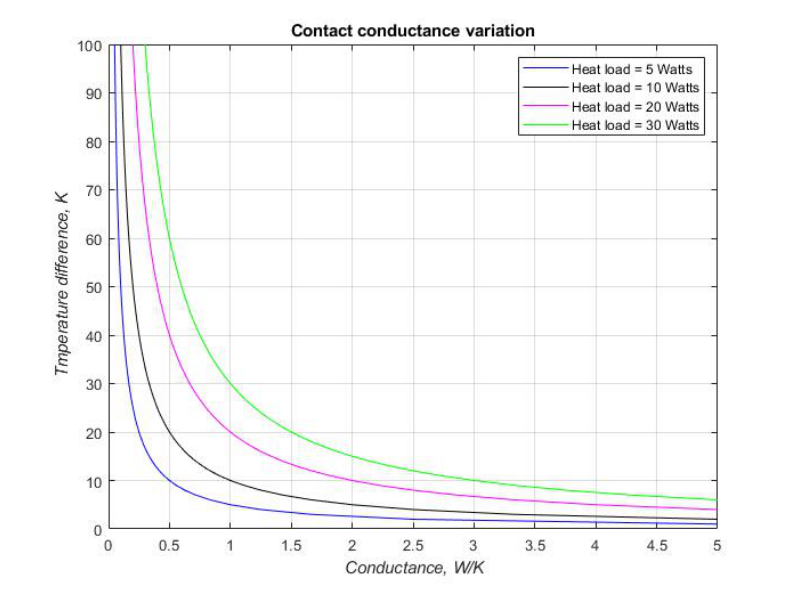
Figure 2. Thermal strap conductance.